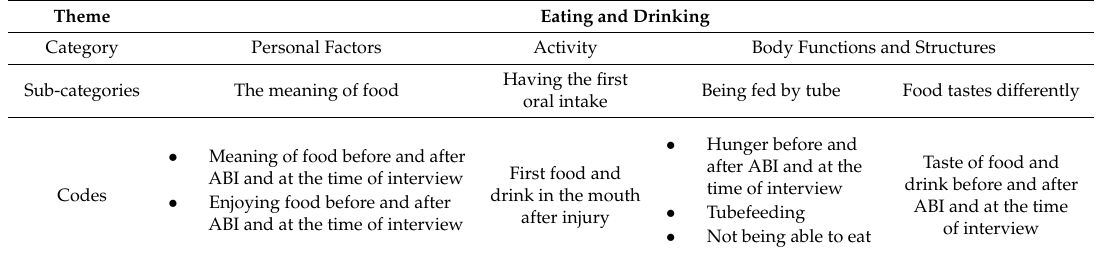
Table 3. An example of the codes, sub-categories and a theme from the content analysis of the interviews.